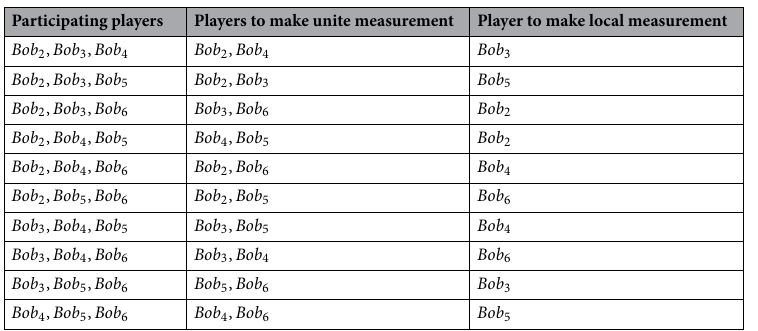
Table 4. Any three users from { Bob 2 , Bob 3 , Bob 4 , Bob 5 , Bob 6 } can unite to recover the secret shared by Bob1 through choosing two users to make Bell measurement and the third to make local measurement.